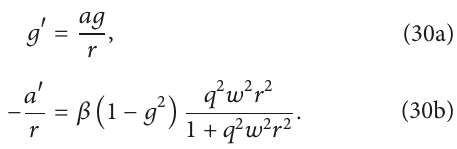
Since the profiles of the functions in (25)-(27) are very similar to the ones that appear in the well-known Nielsen-Olesen case, they are not depicted here, although they are found analytically and easy to